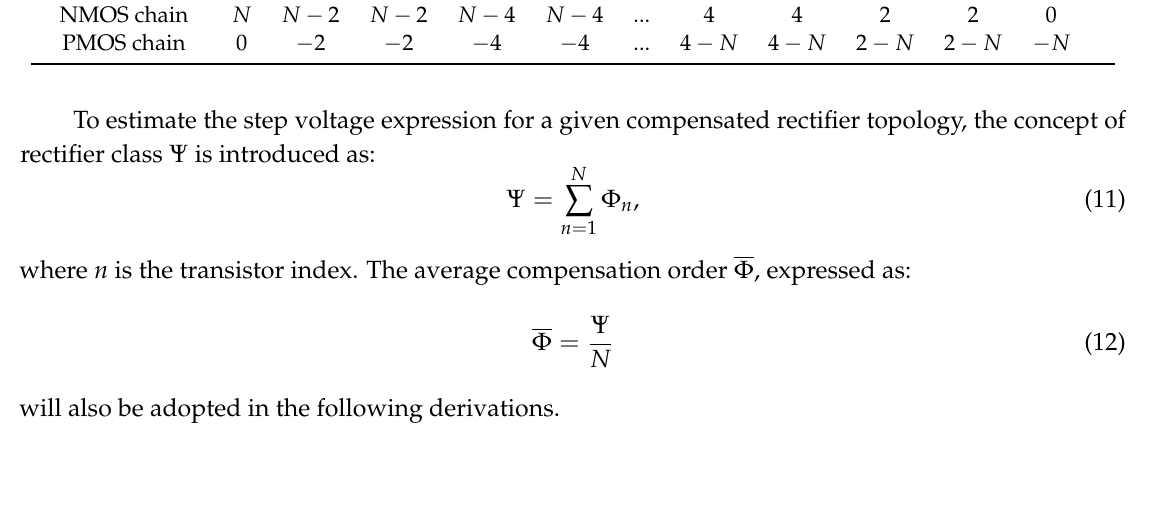
Table 1. Tabular representation of two N -stage voltage multipliers employing maximized compensation chains. Chain Topoogy Rectifier Tabular